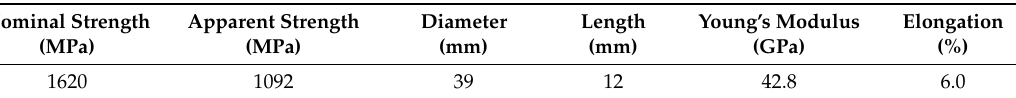
Table 2. Properties of the polyvinyl alcohol (PVA) Fiber